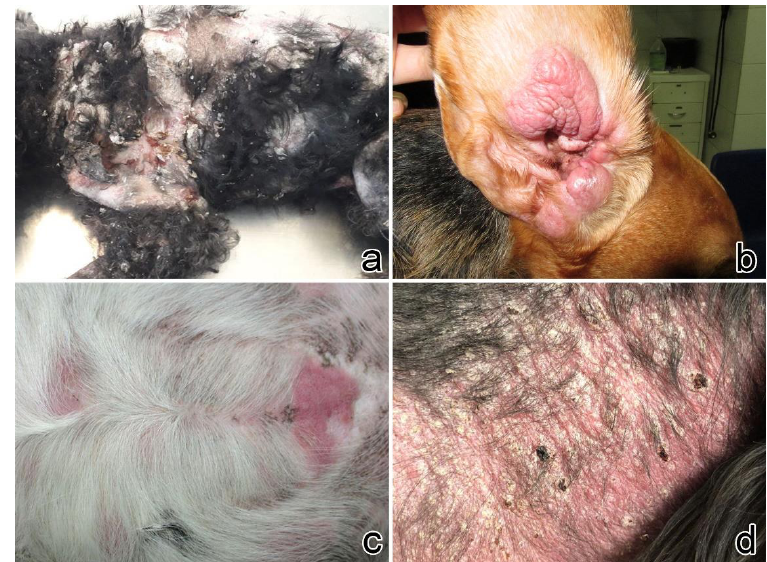
Figure 2. Clinical signs in dogs. ( a ) Case no. 4: severe generalized alopecia with erythematous and exfoliative dermatitis in a Poodle (courtesy Dr. Roberta Gamba). ( b ) Case no. 2: erythematous plaques on the inner surface of the pinna (courtesy Dr. Claudia d’Angeli). ( c ) Case no. 1: multifocal erythematous irregular plaques on the abdomen (courtesy Dr. Francesco Carrani). ( d ) Case no. 6: alopecia, erythema, small yellowish scales on the neck (courtesy Dr. Francesca Carraro).